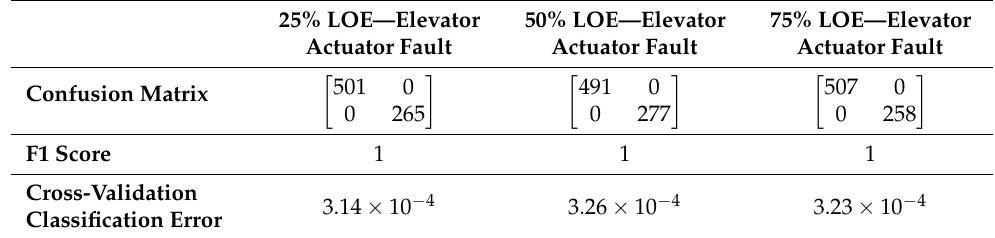
Table 3. Performance evaluation of the SVM models trained for the elevator actuator LOE fault.